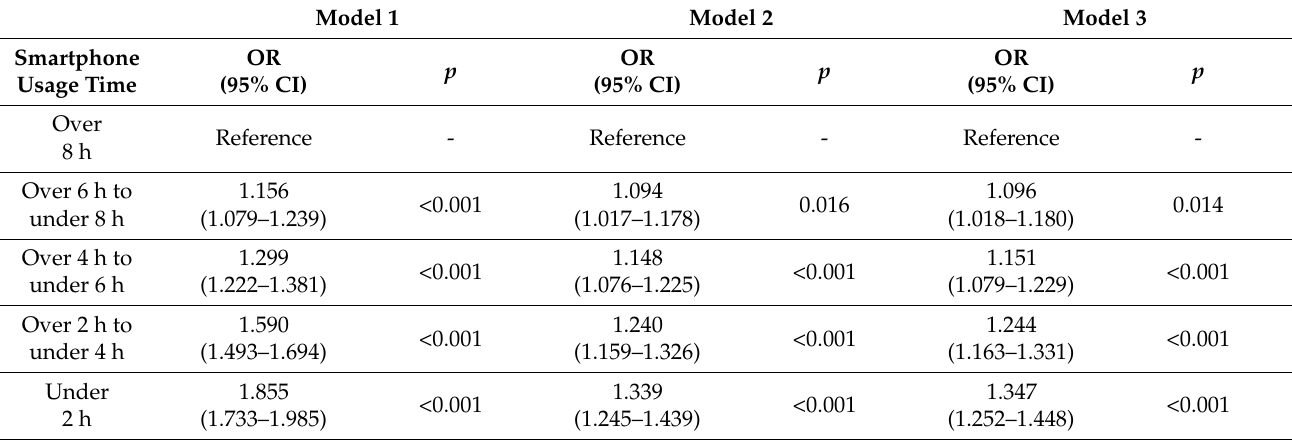
Table 5. Logistic regression analysis of sleep satisfaction based on daily average smartphone usage